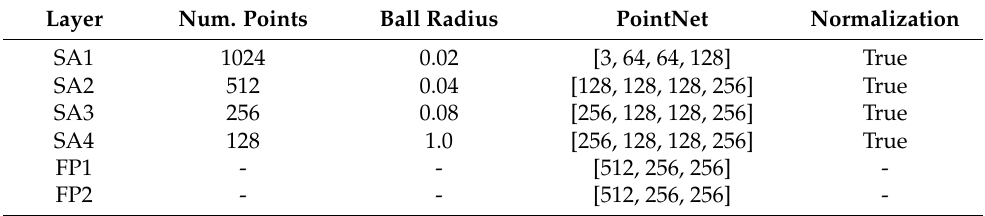
Table 1. Parameters for backbone layers. For each layer, we show the number of points, the ball radius, the number of nodes per layers of the PointNet and normalization